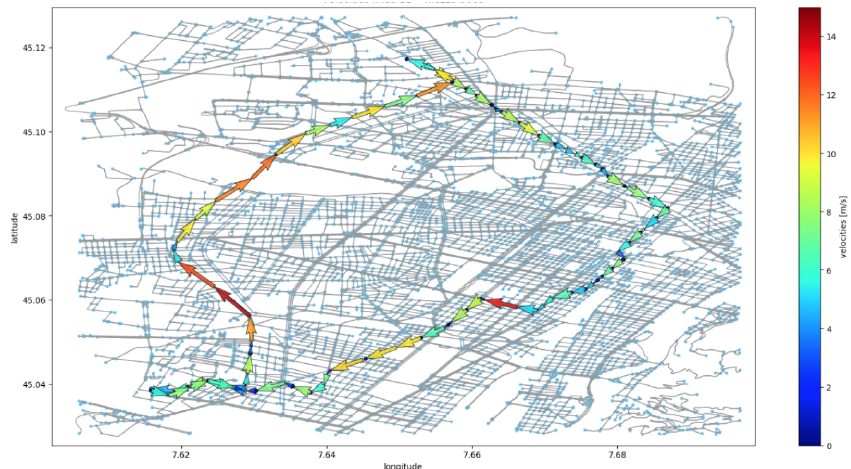
Figure 1. Velocity representation in the case of the vehicle 3063 of line 11.